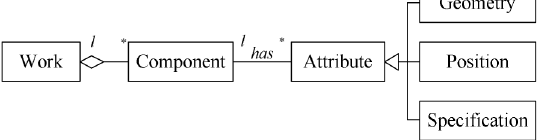
modelFig. 6. Component